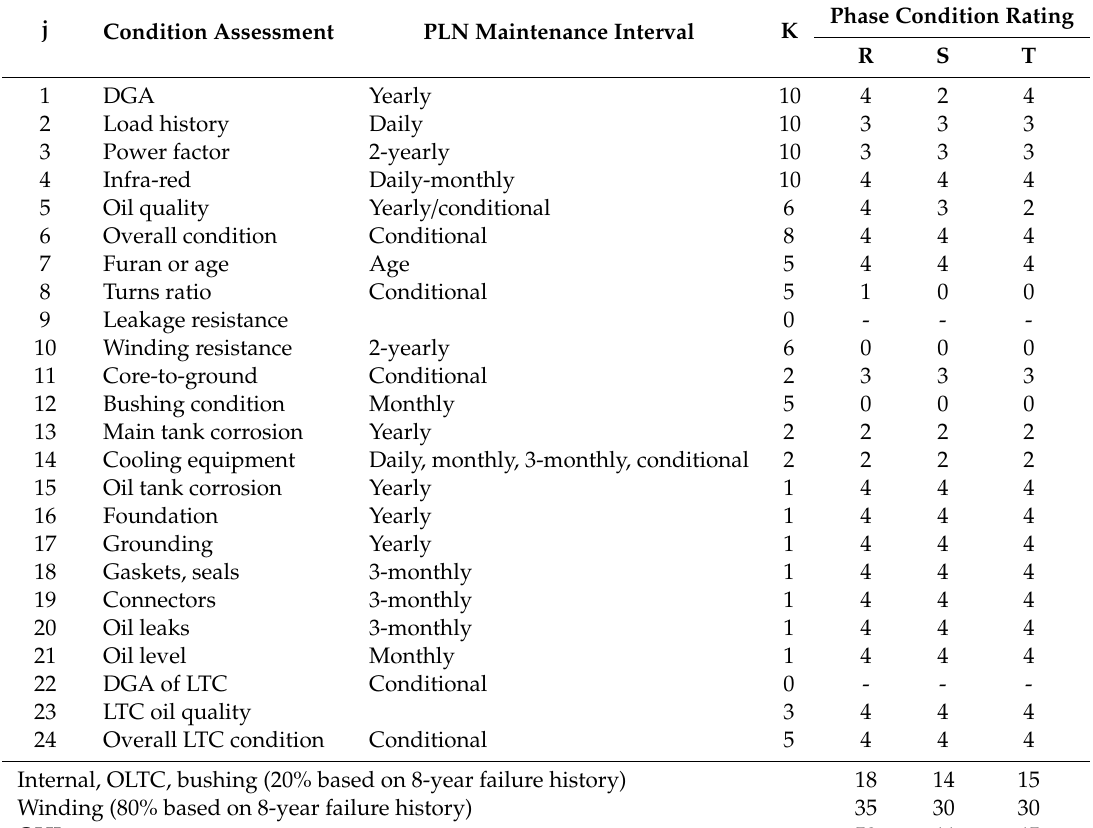
Table 5. OHI estimation based on actual failure distribution between 2008 and